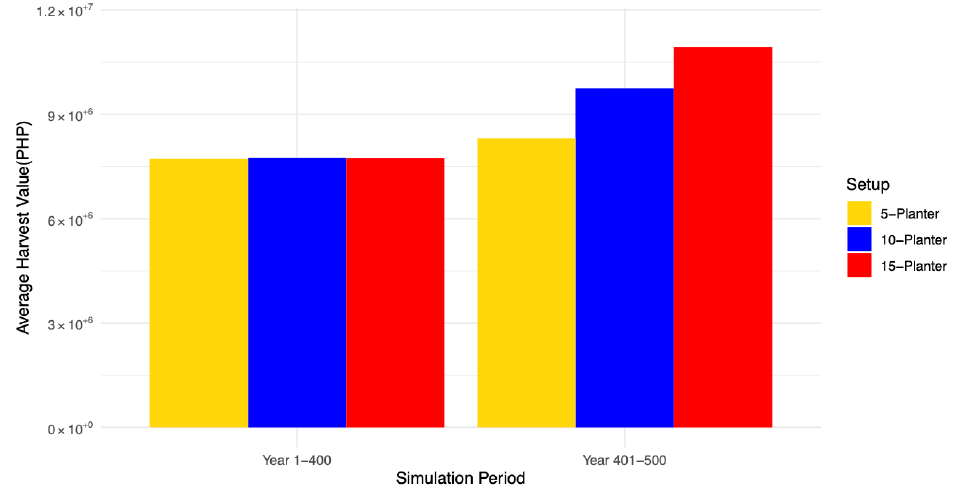
Figure 7. Average harvest value for simulation periods 1 – 400 and 401 – 500 on three setups: 5-planter, 10-planter, and 15-planter.